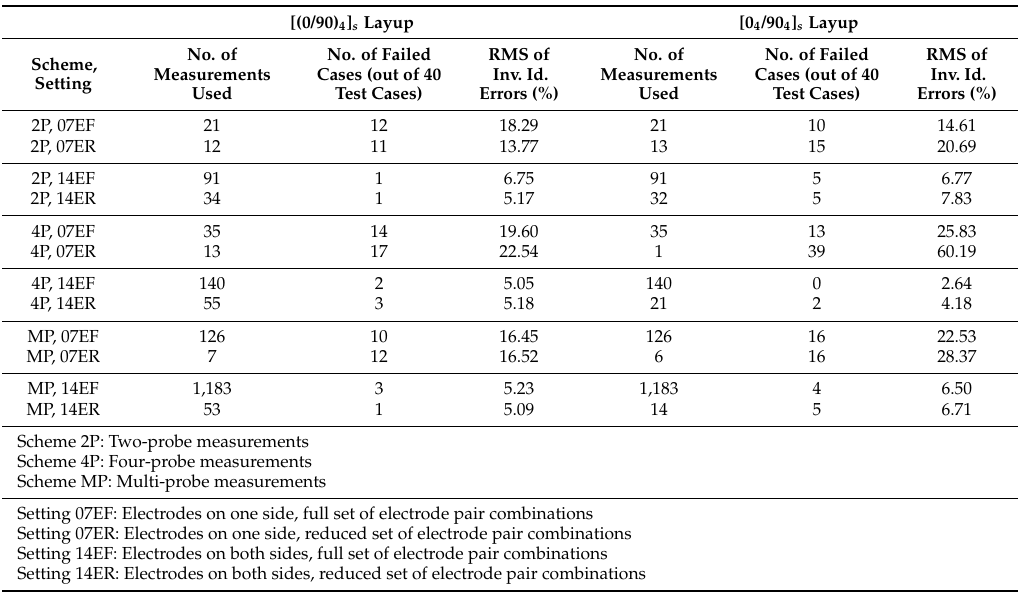
Table 2. Comparison of inverse identification accuracy for different electrode schemes (for [(0/90) 4 ] s and [0 4 /90 4 ] s layups with full and reduced sets of measurements).